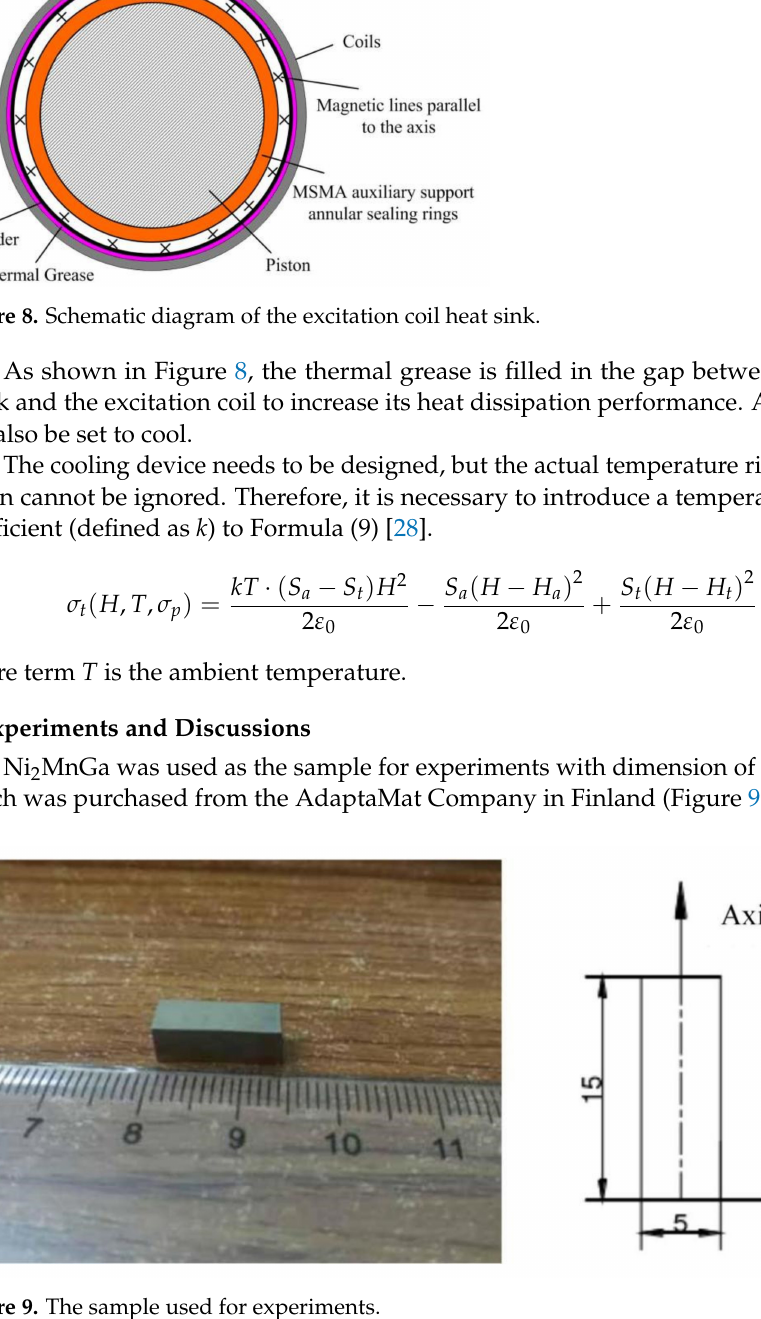
Figure 9. The sample used for